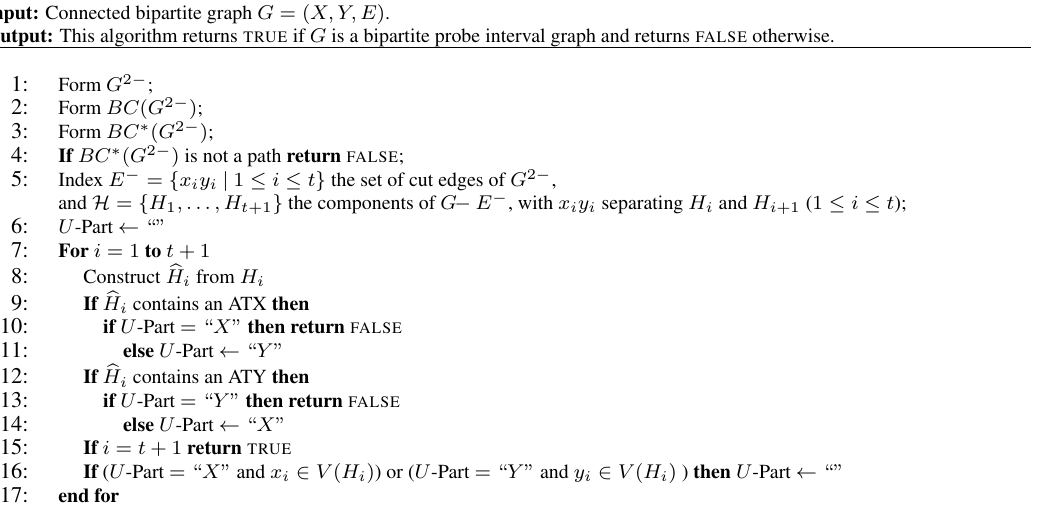
Fig. 6: Algorithm 2: Bipartite probe interval graph recognition